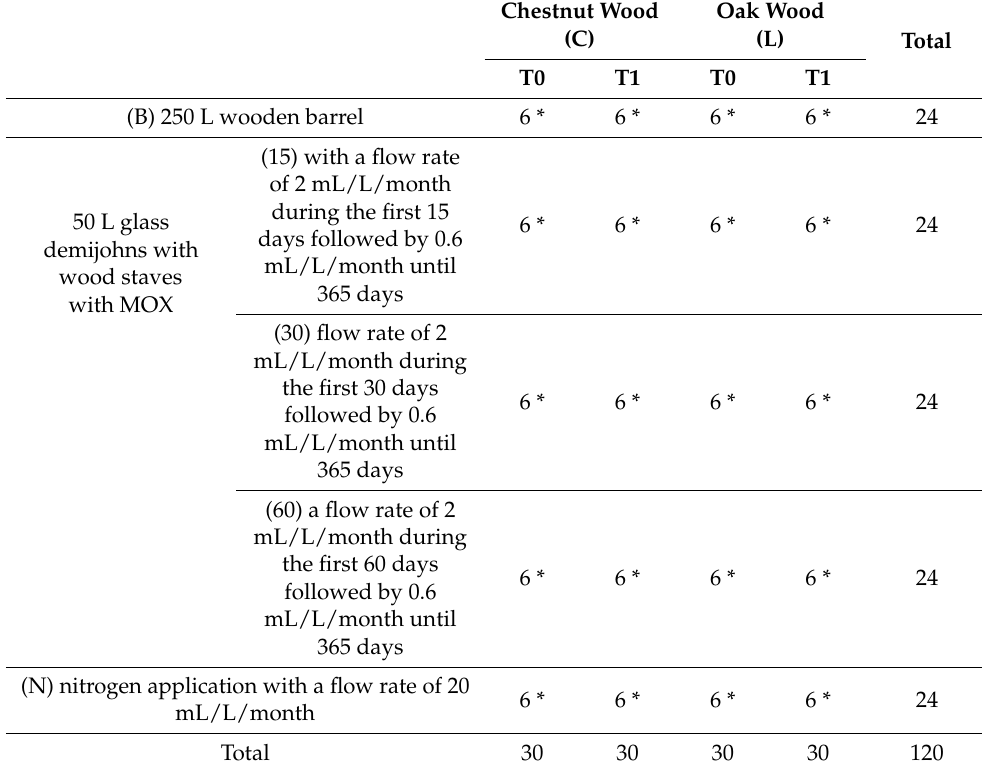
Table 1. Sample characterization and number used in the model